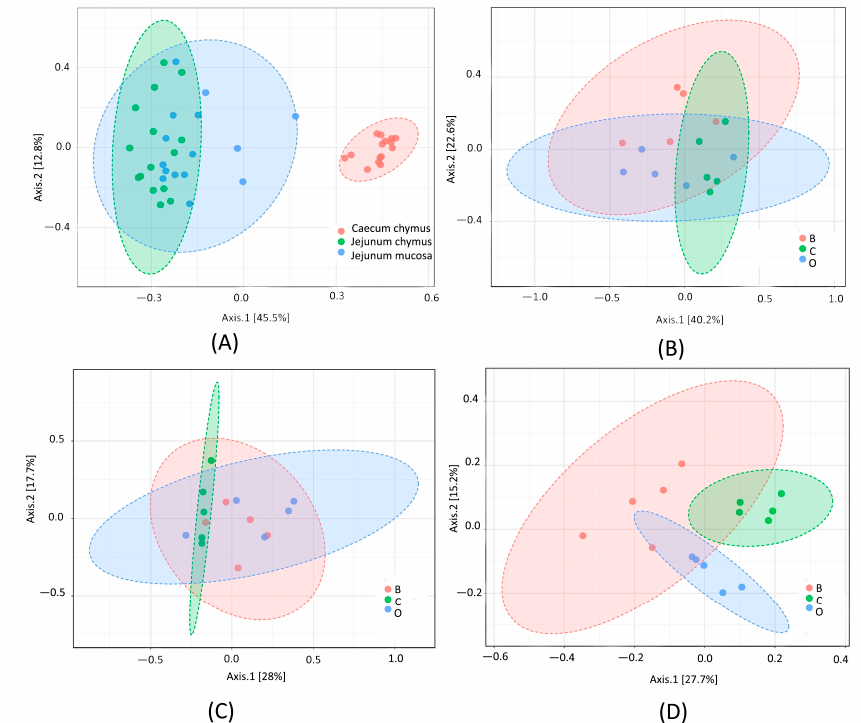
Figure 1. Principal coordinate analysis (PCoA) based on Bray–Curtis dissimilarity matrix of the three sampling places ( A ) and dietary effects in the ileal chymus ( B ), ileal mucosa ( C ), and cecal content ( D ). Permutational multivariate analysis of variance (PERMANOVA) was used to analyze spatial variation in beta diversity of the